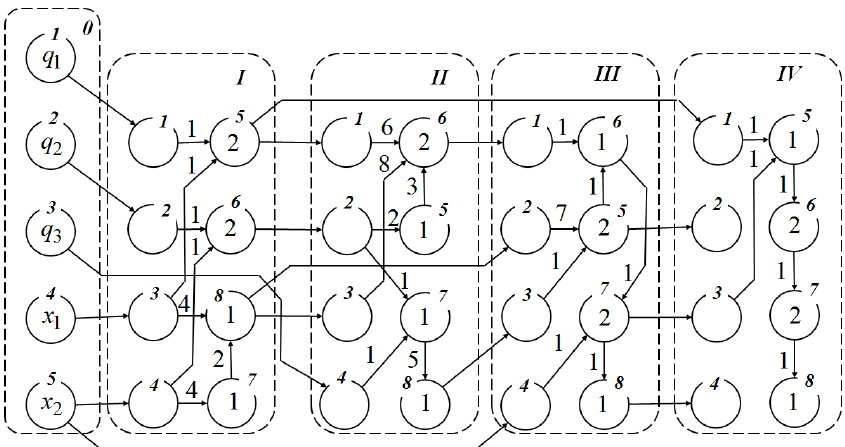
Figure 1. The graph of a multilayer network operator.